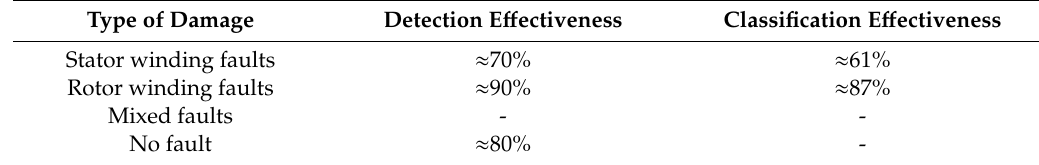
Table 3. E ff ectiveness of the IM winding fault detection and classification using